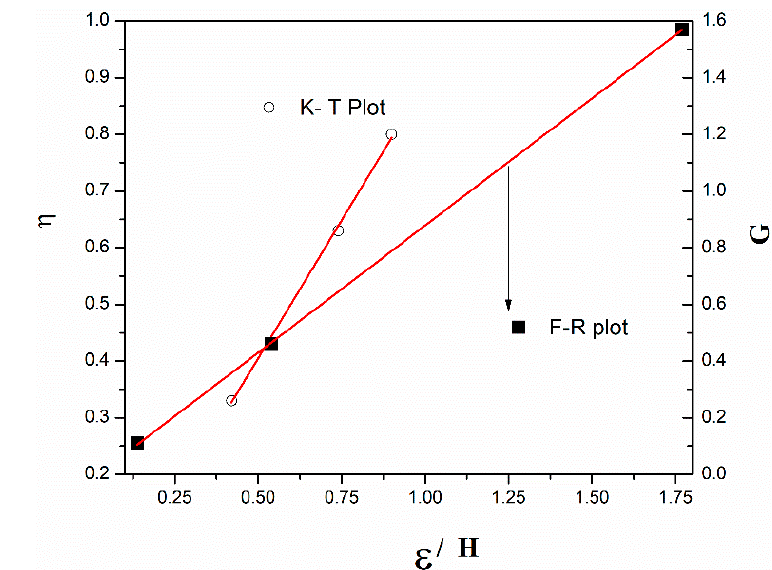
Figure 3. Fineman-Ross and Kelen-Tudos plot for determination of reactivity ratio in the copolymerization of styrene and PDP methacrylate. The r 1 , r 2 values determined from the plots were tabulated in Table 3.